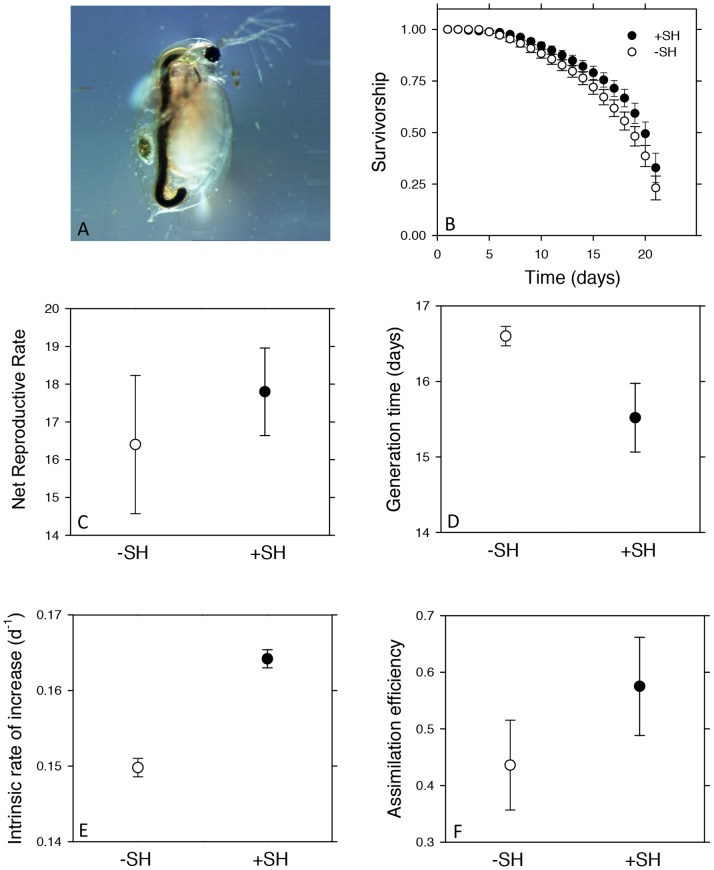
Effects of Super Hume on Daphnia.
A) We observed the accumulation of humic substances in gravid individuals of Daphnia pulex x pulicaria collected from a pond that had been experimentally enriched with Super Hume. Subsequently, we measured the effects of Super Hume (1666 µmol L−1) on the life history (B–D), algal ingestion rates (E), and algal assimilation efficiency (F) where D. pulex x pulicaria was fed algae in the presence (+SH) or absence (−SH) of Super Hume. Values represent means ± SEM.